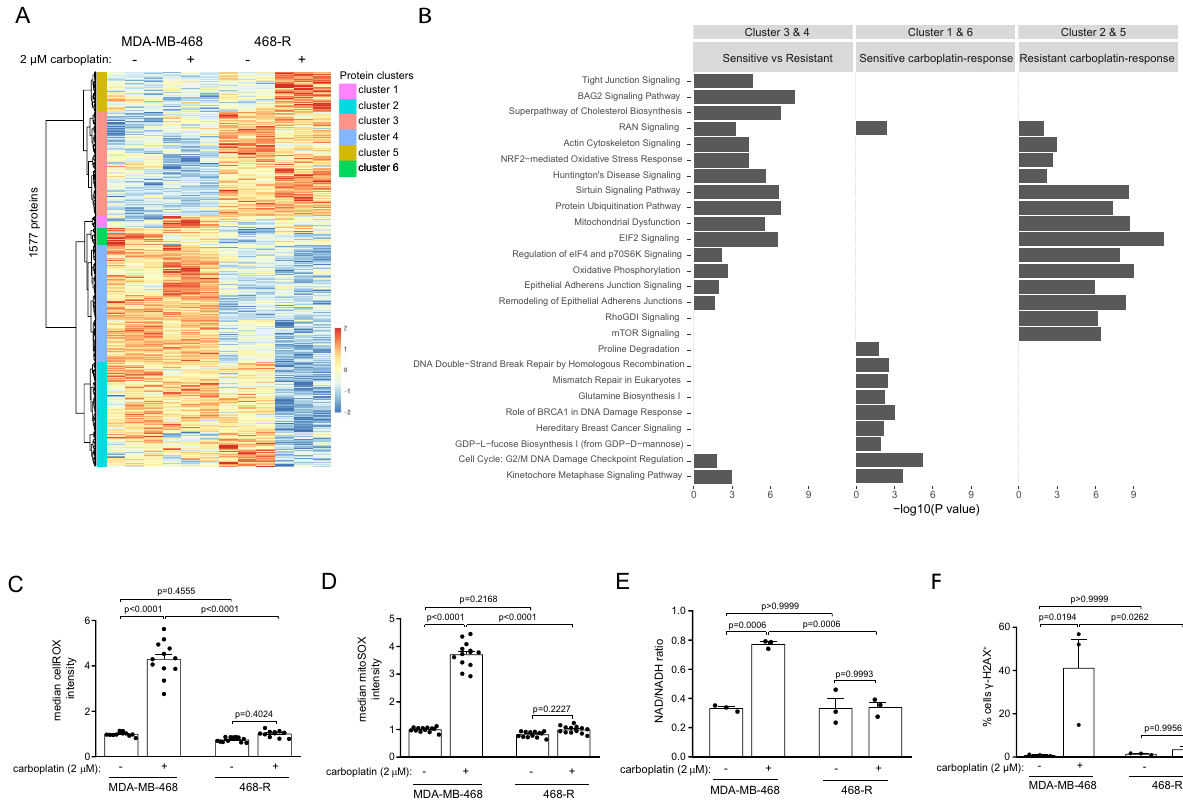
Figure 2. Proteome re-wiring of carboplatin-resistant 468-R cells protects from carboplatin-induced oxidative and genotoxic stress. ( A,B ) Hierarchical clustering of differentially expressed proteins (DE) ( A ) and Ingenuity Pathway Analysis ( B ) of the proteome alterations in MDA-MB-468 and 468-R cells treated with vehicle or 2 µM carboplatin for 5 days. Protein expression was analyzed by LC/MS–MS, and DE proteins were identified by ANOVA followed by Tukey’s HSD test with an adjusted P value < 0.05. The top 10 significantly enriched pathways are shown. P value < 0.05 was used to determine significantly enriched pathways; the –log10 ( P value) was not shown if the pathway was not significantly enriched. N = 3. ( C,D ) ROS levels in MDA-MB-468 and 468-R cells treated with vehicle or 2 µM carboplatin for 5 days. Total ROS levels ( C ) were measured by the cellROX assay, and mitochondrial specific superoxide levels ( D ) were measured by the mitoSOX assay. Median flow of cytometric intensities were normalized to MDA-MB-468 vehicle condition. Data are shown as Mean ± SEM. P values were calculated by two-way ANOVA with Geisser–Greenhouse and Tukey’s correction. N = 3. ( E ) NAD/NADH ratio as measured by NAD/NADH-Glo kit. Data are shown as Mean ± SEM. P values were calculated by two-way ANOVA with Geisser–Greenhouse and Tukey’s correction. N = 3. ( F ) γ-H2AX staining of MDA-MB-468 and 468-R cells treated with vehicle or 2 µM carboplatin for 5 days as analyzed by flow cytometry. P values were determined by two-way ANOVA with Geisser–Greenhouse and Tukey’s corrections. N = 3. Data are shown as Mean ±